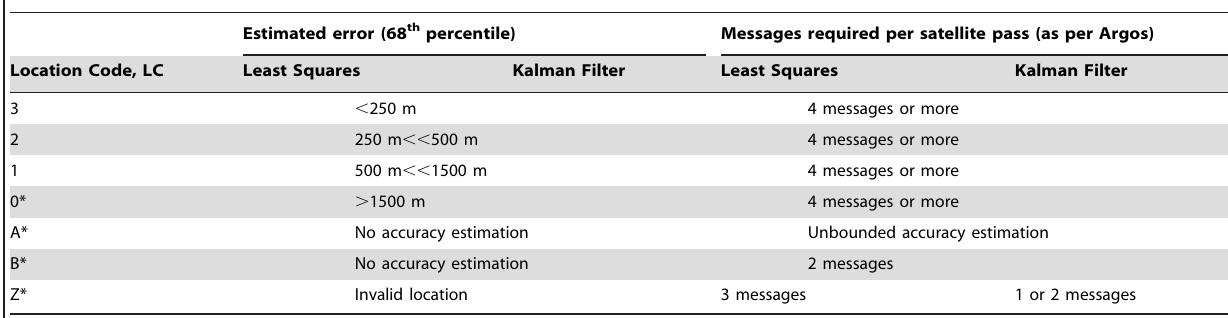
Table 1. Classification and 1-dimensional accuracy of location classes as provided by Argos.